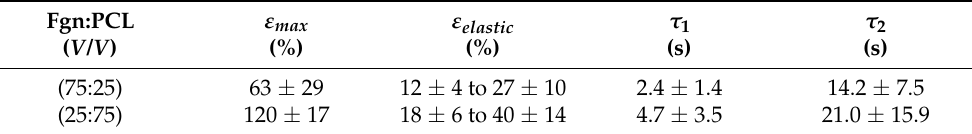
Table 1. Mechanical properties that exhibit ratio dependence, but no diameter dependence. Maximum strain (extensibility), ε max , elastic limit, ε elastic , and fast and slow relaxation times, τ 1 and τ 2 for electrospun 75:25 and 25:75 fibrinogen:PCL nanofibers.